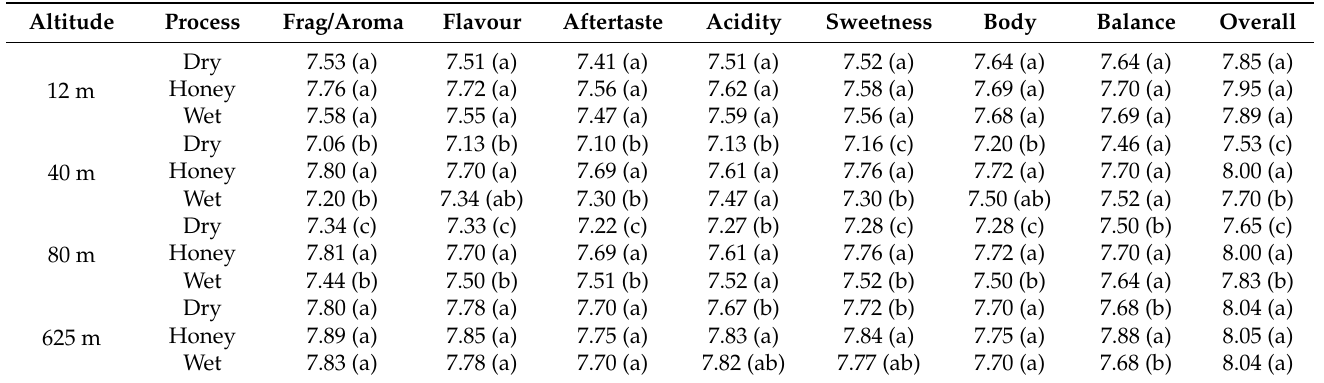
Table 3. Summary of means from Tukey’s HSD test for